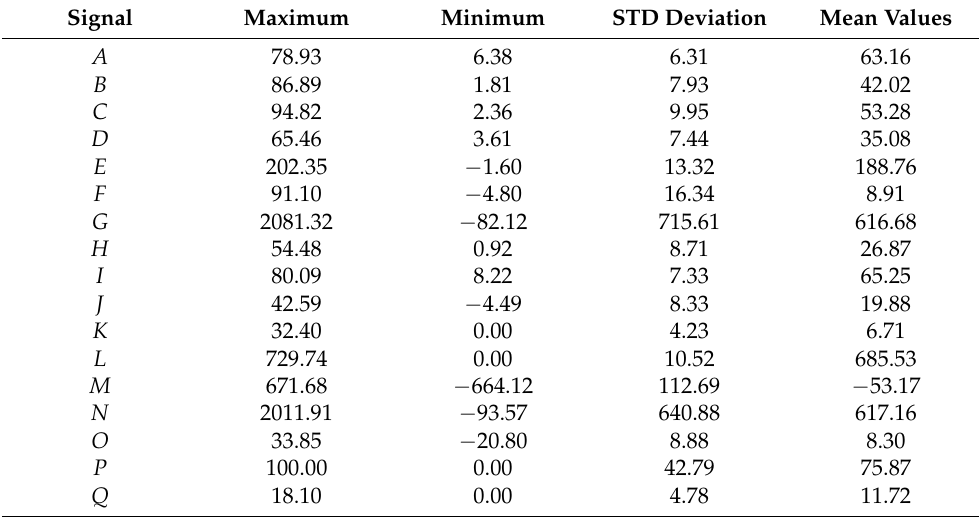
Table A1. Measured signals’ maximum, minimum, standard deviation, and mean